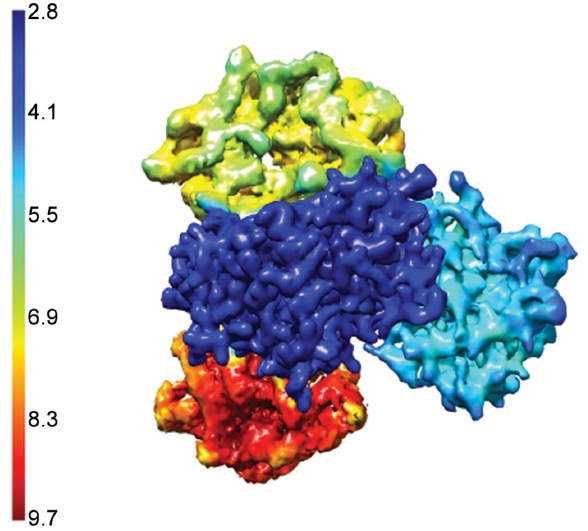
Figure 1 Large differences in local resolution are typically observed in cryoEM maps and the work of Urzhumtsev and Lunin allows the refinement of the local resolution of the map as an atomic parameter. In the figure, resolution variations are represented as identified by DeepRes from the simulated map of the 39 kDa human cartilage glycoprotein tetramer filtered at 3, 5, 7 and 9 A˚ . Reproduced from Ramı´rez-Aportela et al.